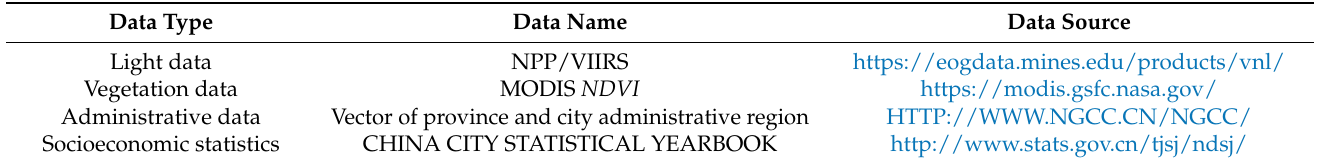
Table 2. Data name and